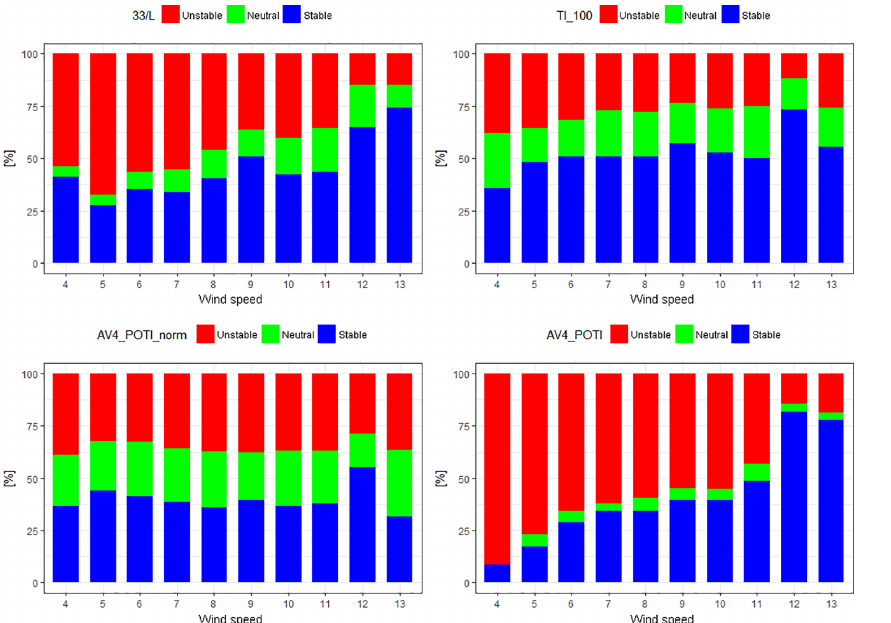
Figure 6. Distribution of stability based on ζ as a function of wind speed for different parameters of interest.